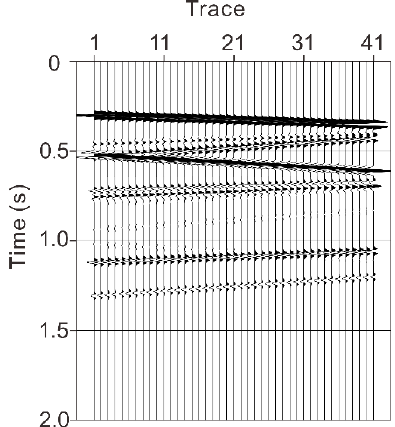
Figure 5. Synthetic VSP record based on model 1.